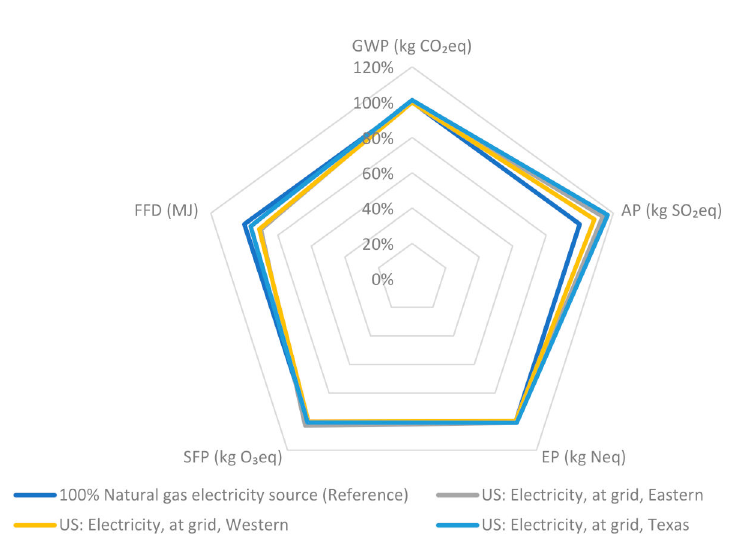
Figure 12. Sensitivity analysis results of using di ff erent electricity gird mix.